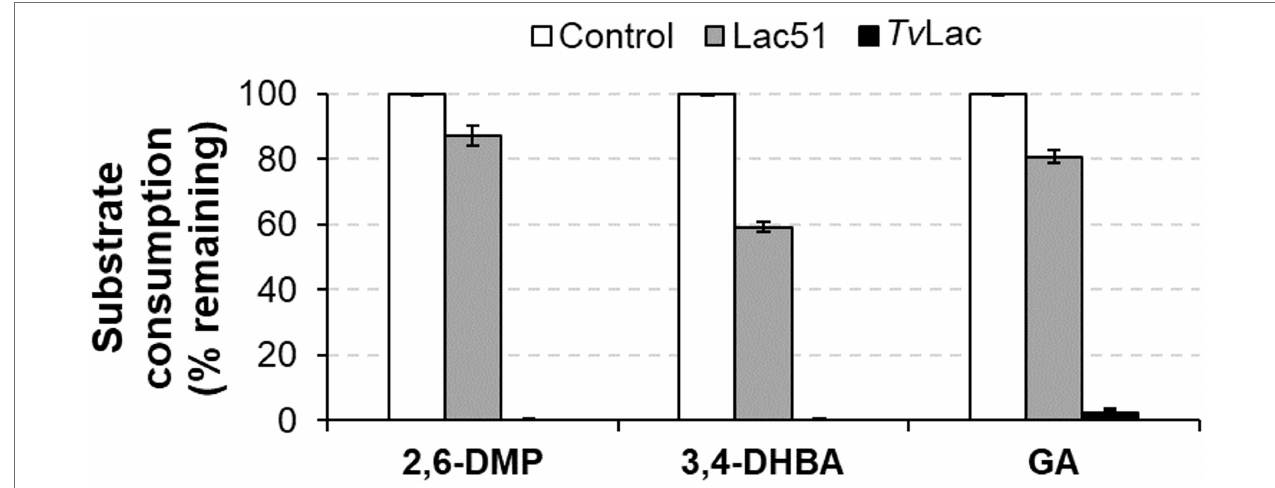
FIGURE 6 | Activity of Lac51 and Tv Lac on 2,6-dimethoxyphenol (2,6-DMP), 3,4-dihydroxybenzaldehyde (3,4-DHBA), and gallic acid (GA). Lignin monomers (3 mM) were incubated with 2 μ M Lac51 or Tv Lac in 10 mM BisTris-HCl buffer pH 6.5 at 37 ° C for 24 h. The reaction was followed by detecting the consumption of substrate at 315 nm for 2,6-DMP and GA and at 450 nm for 3,4-DHBA. The control reactions contained the substrates without enzyme. Reactions were run in triplicate; error bars represent SDs.